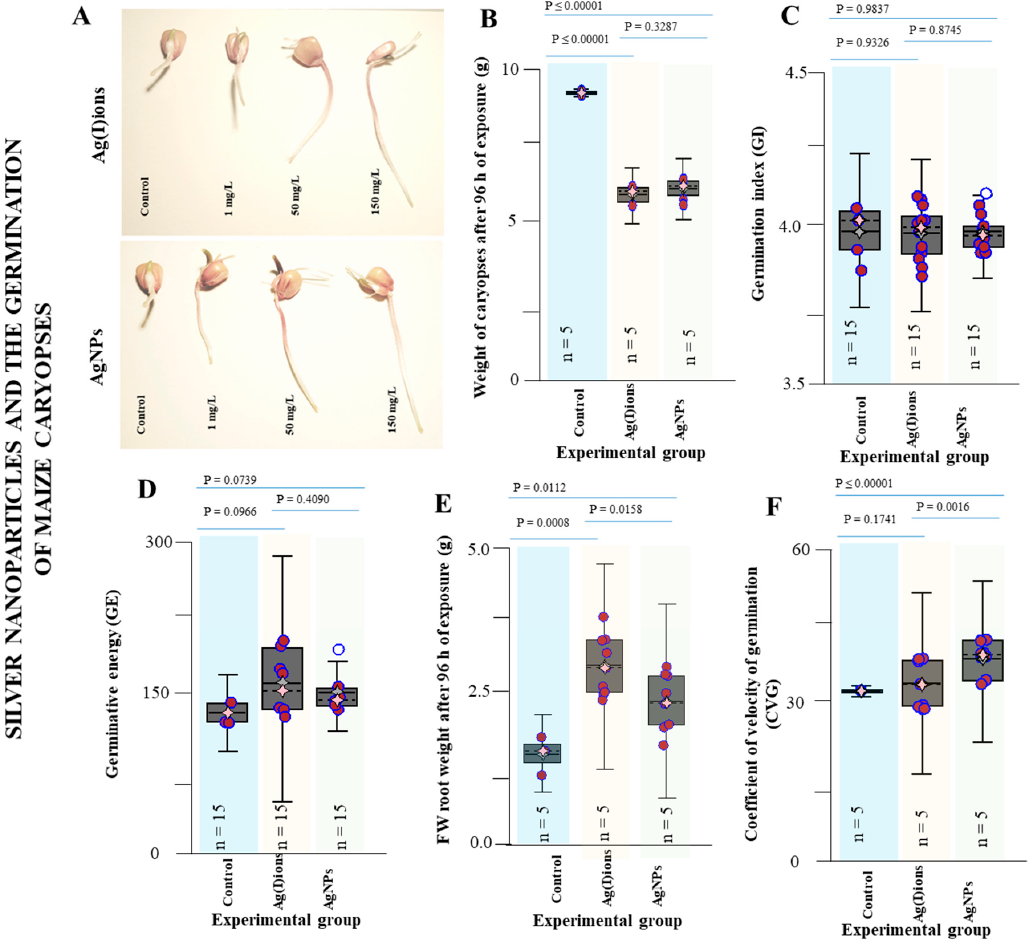
Figure 5 . A typical experimental arrangement of Ag(I) ions and AgNPs toxicity tests on germinated Figure 5. A typical experimental arrangement of Ag(I) ions and AgNPs toxicity tests on